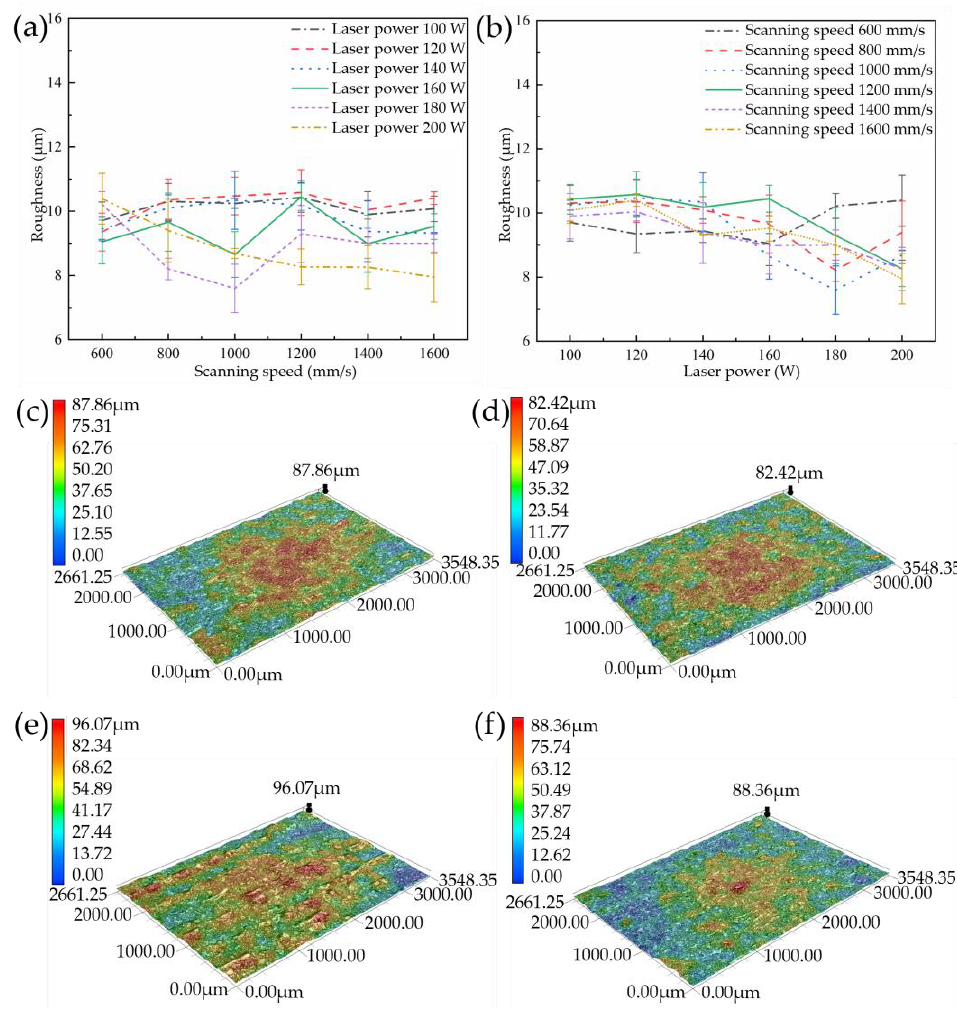
Figure 6. Morphology and roughness of vertical side under different parameters: ( a ) scanning speed; ( b ) laser power; ( c ) 100 W, 600 mm/s; ( d ) 100 W, 1600 mm/s; ( e ) 200 W, 600 mm/s; ( f ) 200 W, 1600 mm/s.